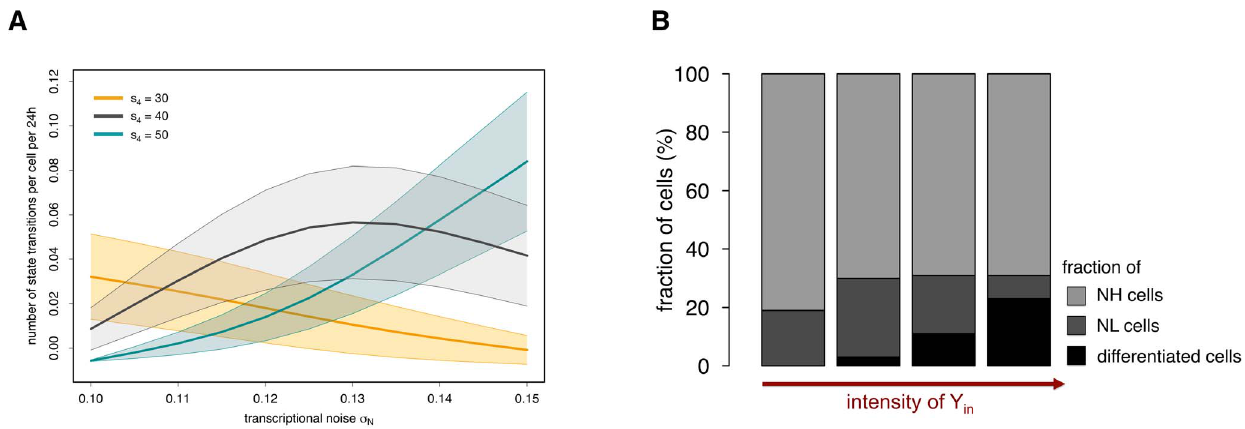
Figure 5. Rate changes in the LIF/serum scenario. (A) The number of state transitions depends on the background noise s N . In the bistable region, for any value of the autoregulatory transcription rate s 4 (e.g. orange line: s 4 =30; grey line: s 4 =40; blue line: s 4 =50), an increase in the noise intensity s N up to a certain range leads to an increase in the number of state transitions. If the intensity of the background noise becomes too high, it interferes with the underlying TF dynamics and the number of valid transitions decreases. Thick middle lines show the mean number of state transitions in 24 h for the respective value of s 4 , upper and lower bands depict the standard deviations. (B) Simulation results demonstrate that the fraction of terminally differentiated cells depends on Y in , which is determined by the culture conditions (i.e. intensity of signal Y) and by the Nanog concentration. Cell fractions are determined after simulating 3 days of in silico culture with the parameter set for the LIF/serum scenario.